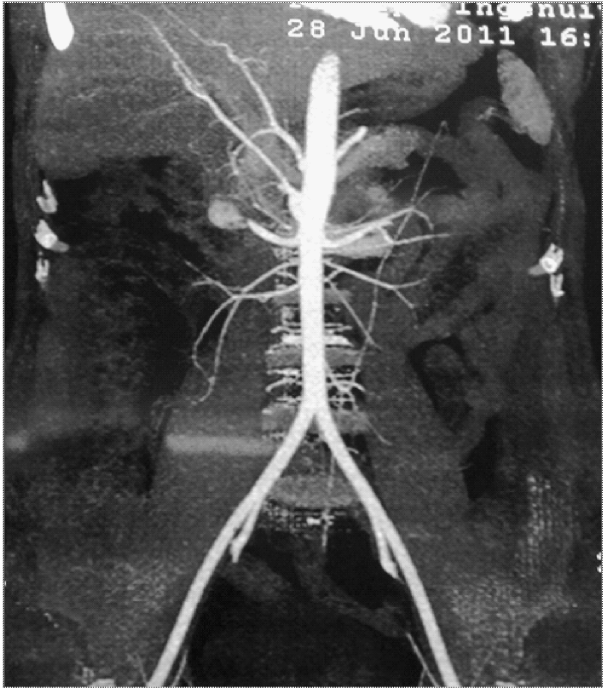
Figure 1. Contrast enhanced CT revealed a solitary insulinoma in the head of pancreas.